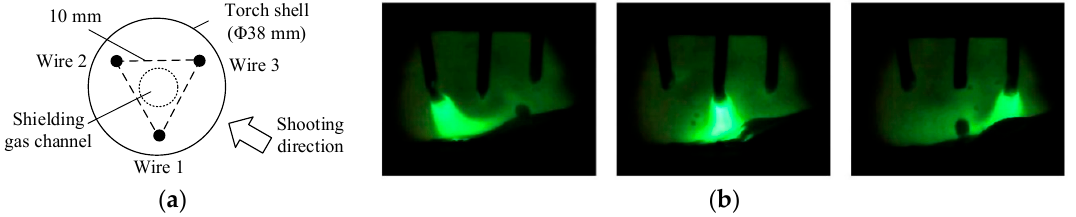
Figure 2. Alternating combustion of the pulsed arc among three wires, ( a ) arrangement position of welding wires, ( b ) welding arcs at different pulse moments.